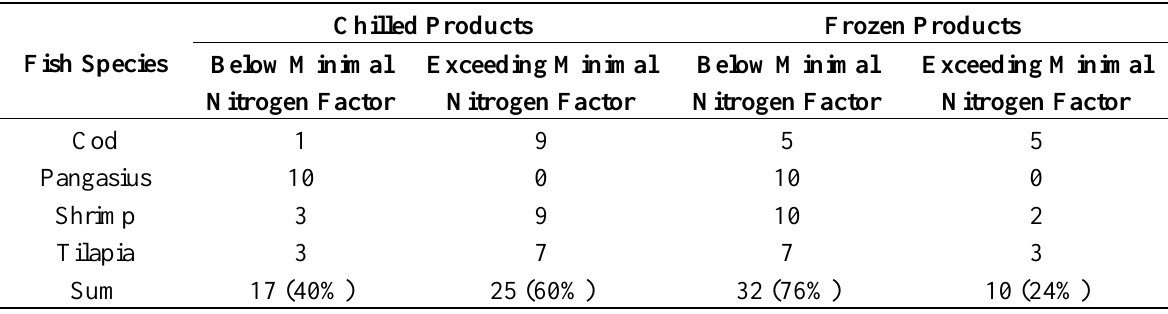
Table 4. Comparison of the nitrogen contents of seafood samples with Kjeldahl nitrogen factors for GMP fish ingredients [7,25]: the number of samples with nitrogen contents below or over minimal nitrogen factors 1